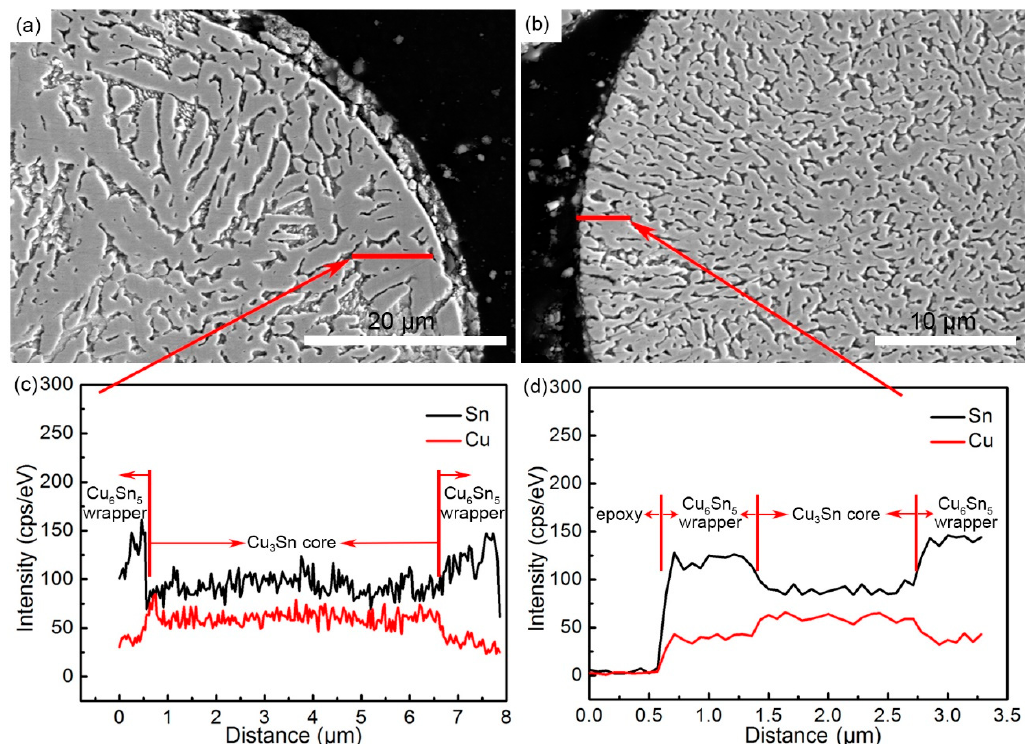
Figure 6. Typical microstructures of cross-sectional powder with sizes of ( a ) 82 µ m and ( b ) 59 µ m. ( c , d ) Corresponding energy-dispersive X-ray spectroscopy (EDS) line-scanning of the marked lines in ( a , b ).